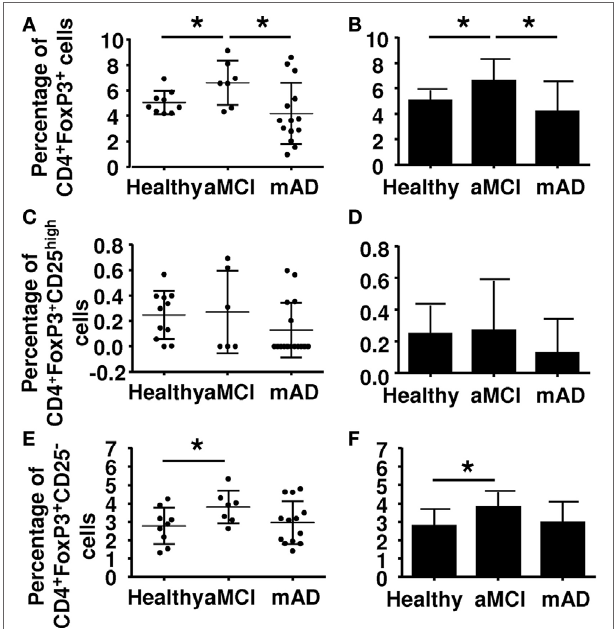
FigUre 2 | Determination of the percentage of regulatory T cells (Tregs) in peripheral blood mononuclear cell of healthy, amnestic mild cognitive impairment (aMCI), and mild AD (mAD) subjects. (a) Tregs percentages defined by the CD4 + FoxP3 + markers in individual participants. (B) Corresponding histograms. (c) Tregs percentages defined by the CD4 + Foxp3 + CD25 high markers in individual participant. (D) Corresponding histograms. (e) T regs percentages defined by CD4 + Foxp3 + CD25 − markers in individual participants. (F) Corresponding histograms. Each group was composed of at least five independent subjects with determinations made in triplicate. Data are shown as the mean ± SEM. The asterisks (*) correspond to p <